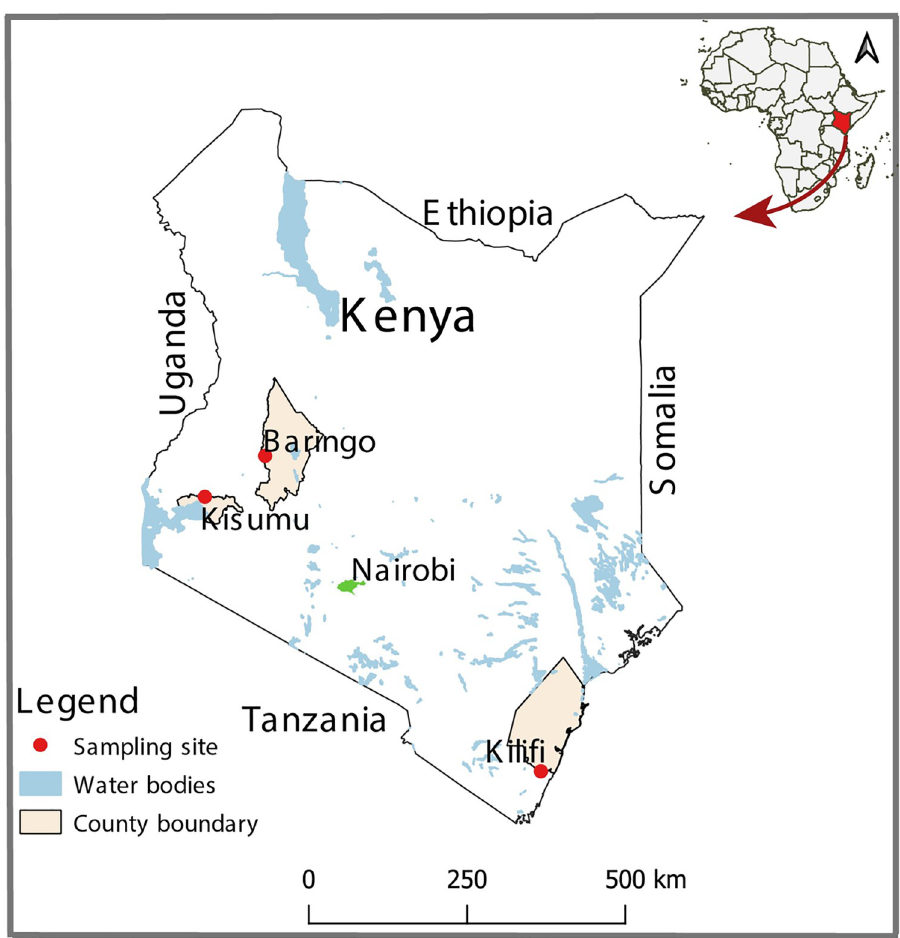
Fig 1. Map of Kenya showing mosquito sampling sites: Kerio Valley (Baringo), Rabai (Kilifi) and Kajulu (Kisumu). The map was designed using ArcMap 10.2.2 with the ocean and lakes base layer derived from Natural Earth (http://www.naturalearthdata.com/, a free GIS data source). The sample points were collected using a GPS gadget (garmin etrex 20, https://buy.garmin.com/en-US/US/p/518046), and the county boundaries for Kenya derived from Africa Open data (https://africaopendata.org/dataset/kenya-counties-shapefile, license Creative Commons).